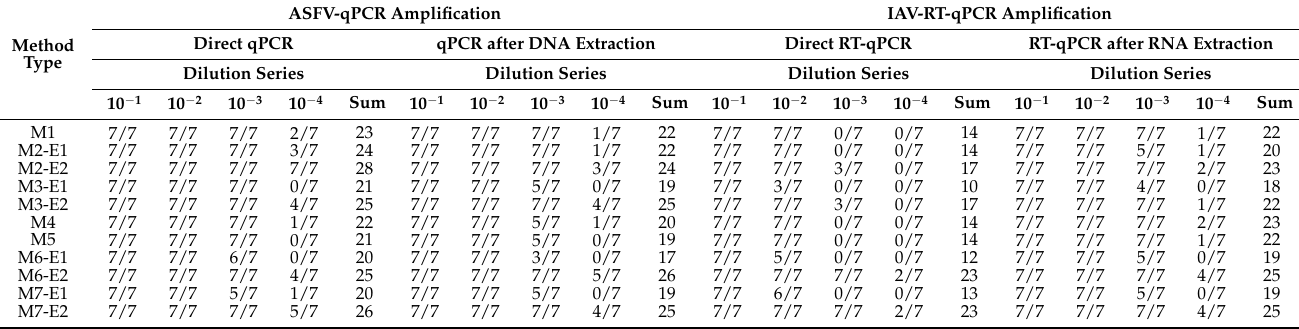
Table 1. Qualitative PCR results for 11 DNA/RNA releasing methods using seven different FTA cards and four dilution steps of ASFV DNA and IAV RNA (the positive cards based on each isolation method and dilution series are presented, number of PCR positives/number of FTA brands used).